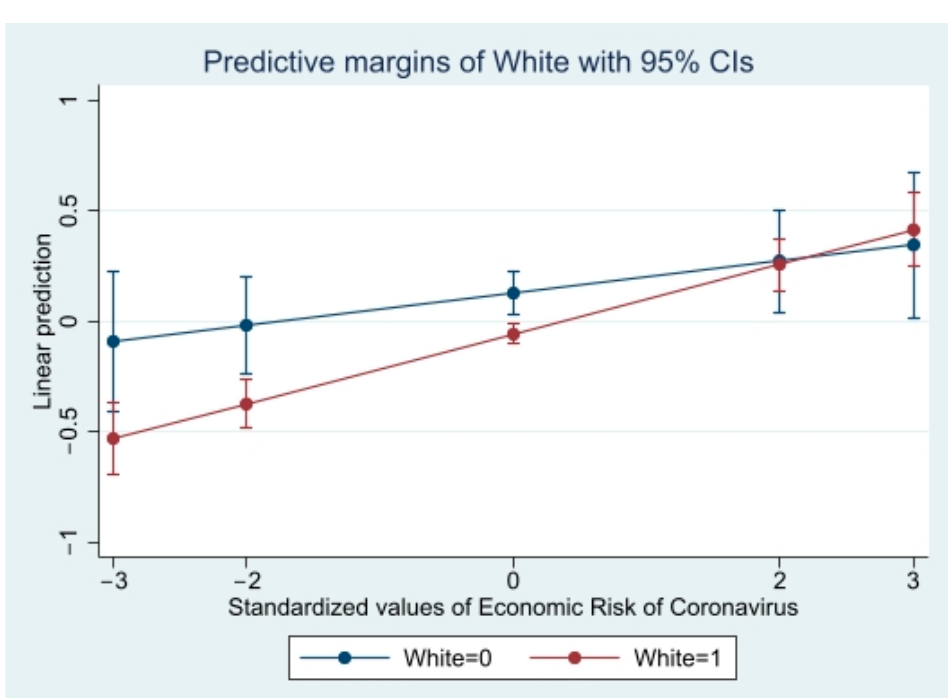
Figure 3. Predicted Coronavirus Anxiety by Perceived Economic Risk of Coronavirus and Race